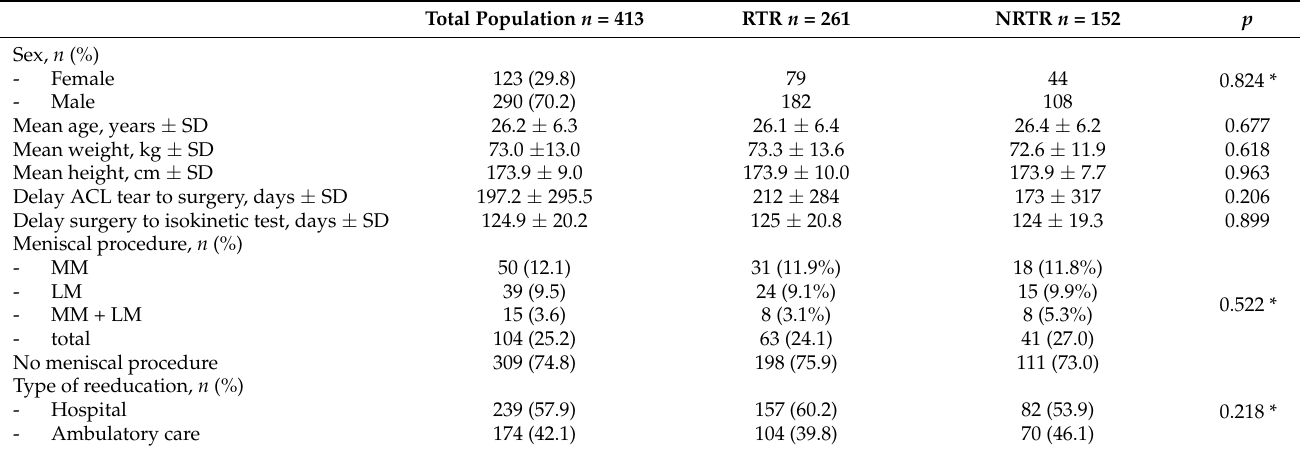
0.824 *- Female 123 (29.8)